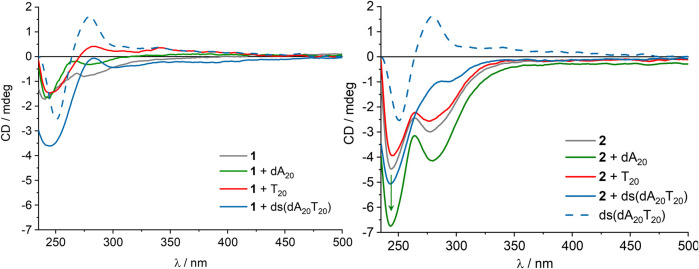
CD of 1
(left) and 2
(right), each 15.0 µM in aqueous solution (2% DMSO), and in the presence of 0.75 μM dA20, 0.75 μM T20 or 0.75 μM ds (dA20T20), and reference spectrum of 0.75 μM ds (dA20T20).